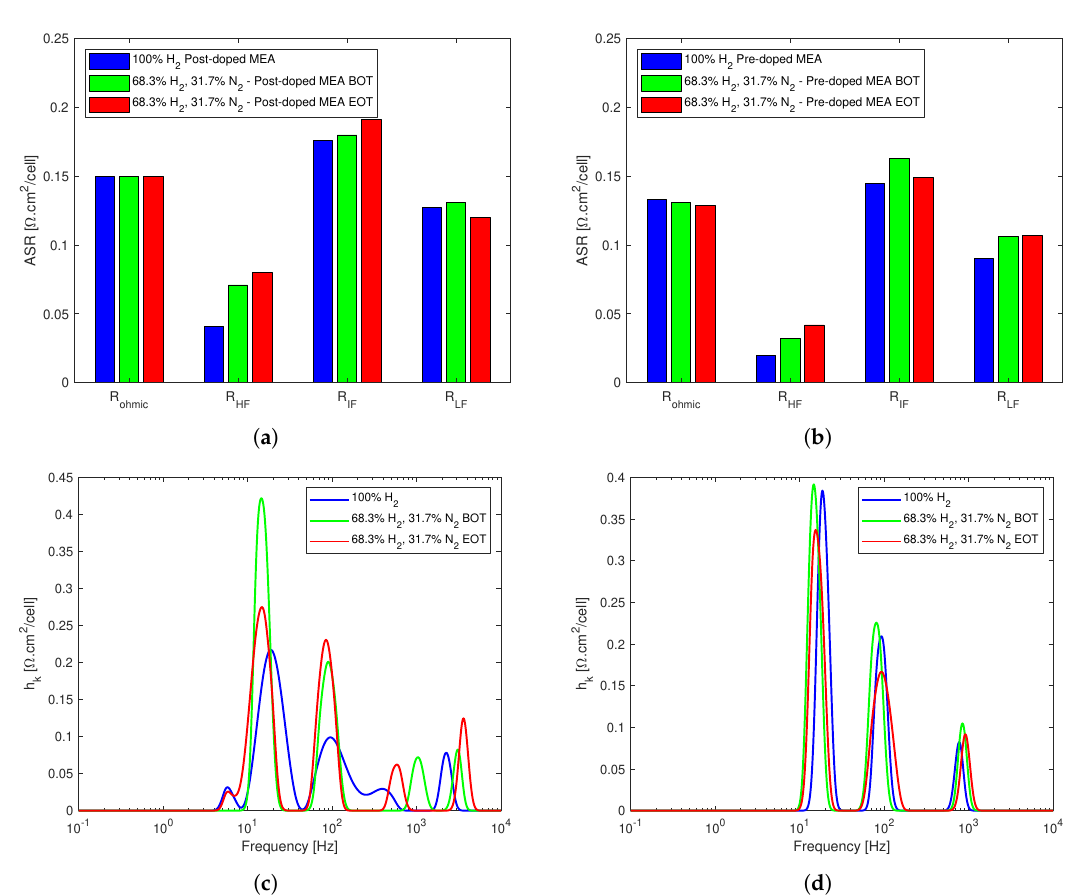
Figure 5. EIS data analysis for the effects of N 2 dilution on both stacks. ( a ) EC model fitted resistances for the post-doped MEA-based stack. ( b ) EC model fitted resistances for the pre-doped MEA-based stack. ( c ) DRT analysis of the post-doped MEA-based stack. ( d ) DRT analysis of the pre-doped MEA-based